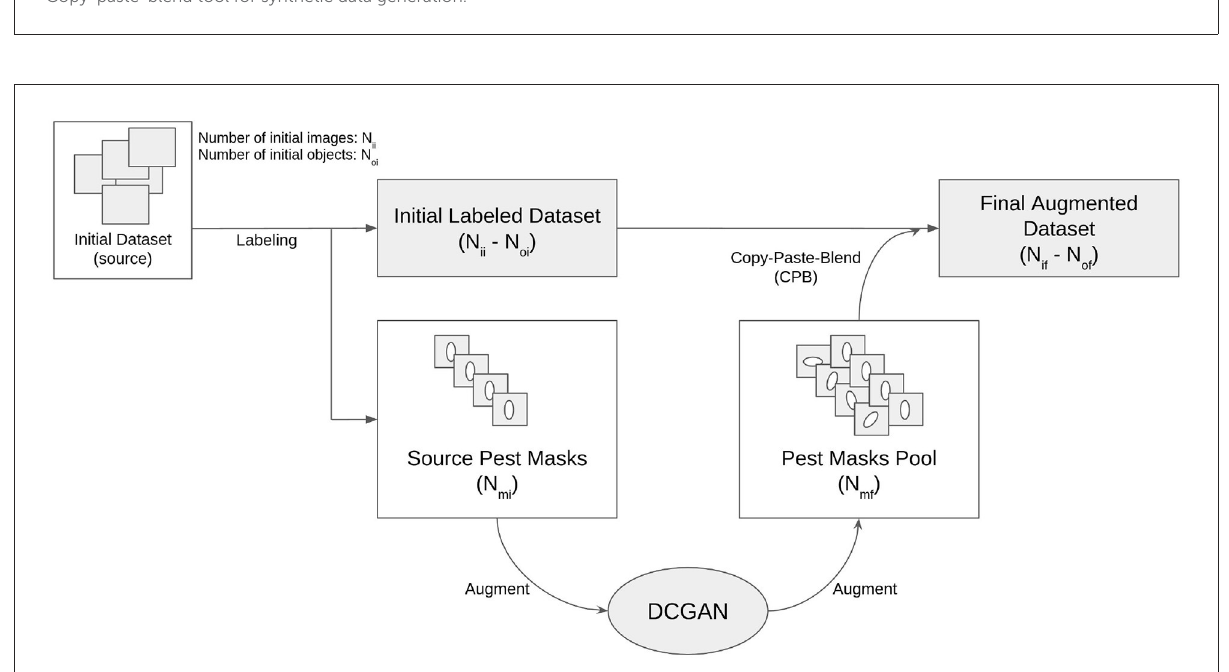
FIGURE2 Copy-paste-blend + DCGAN augmentation pipeline (CPB + GAN).